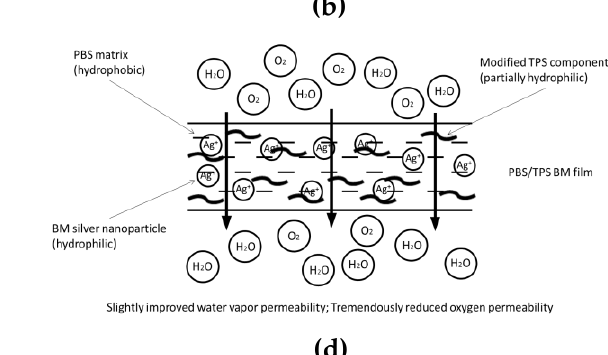
Figure 7. Staphylococcus aureus (ATCC 6538P) growth on different PBS films. Note: At start: the cell number of culture before incubation (5 log CFU/mL); No sample: no PBS film; PBS: PBS film without antimicrobial agent; PBS 1.5% BM: PBS with 1.5% BM; PBS 3% BM: PBS with 3% BM; PBS/TPS: PBS with tapioca starch; PBS/TPS 1.5% BM: PBS/tapioca starch with 1.5% BM; PBS/TPS 3% BM: PBS/tapioca starch with 3% BM; G: Gentamicin. Error bars represent standard deviation (n = 3). The different a – f small letters indicate significant difference ( p < 0.05) among film samples. Figure 8. Escherichia coli (ATCC 11229) growth on different PBS films. Note: At start: the cell number of culture before incubation (5 log CFU/mL); No sample: no PBS film; PBS: PBS film without antimicrobial agent; PBS 1.5% BM: PBS with 1.5% BM; PBS 3% BM: PBS with 3% BM; PBS/TPS: PBS with tapioca starch; PBS/TPS 1.5% BM: PBS/tapioca starch with 1.5% BM; PBS/TPS 3% BM: PBS/tapioca starch with 3% BM; G: Gentamicin. Error bars represent standard deviation (n = 3). The different a – f small letters indicate significant difference ( p < 0.05) among film samples.